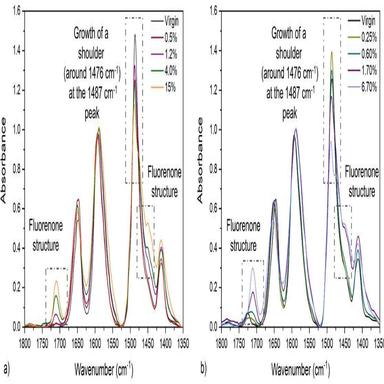
Spectral changes that occur at a) PEEK and b) CF-PEEK upon thermal degradation when heated with 50 ◦C/min up to a 0.5%, 1.2%, 4%, 15% and a 0.25%, 0.6%, 1.7%, 6.7% mass loss respectively (1800-1350 cm-1).